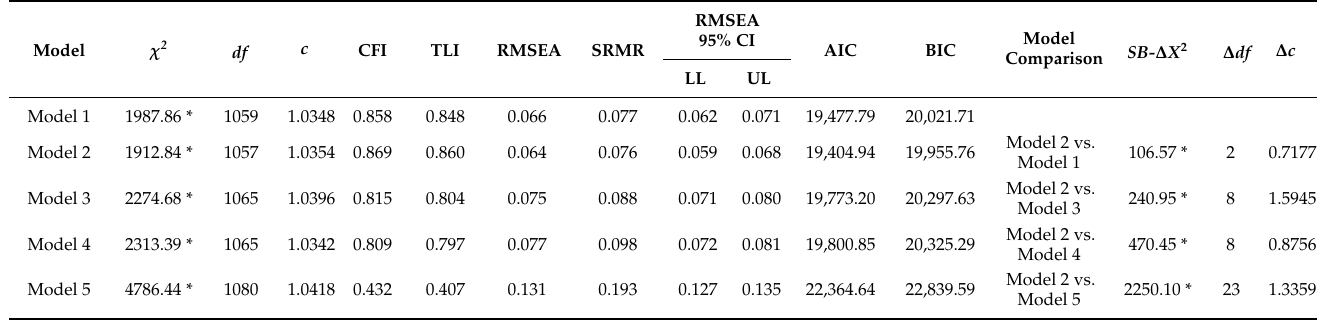
Table 1. Competing measurement models.